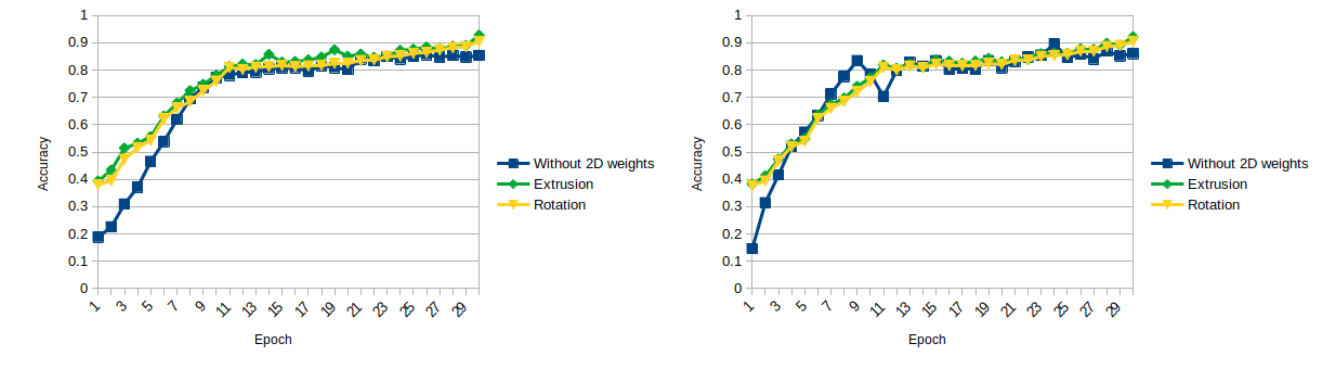
Figure 16. EfficientNetB0 3D